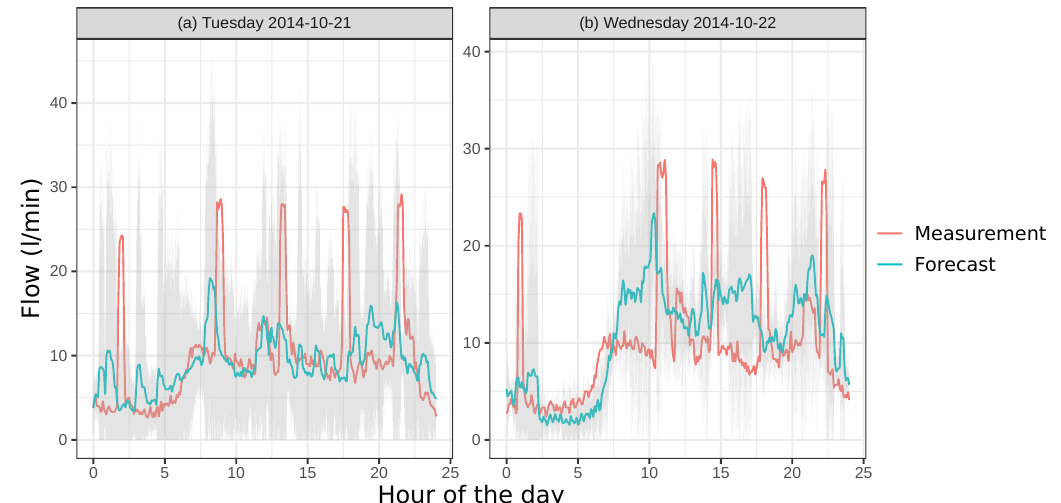
Figure 7. Comparison of two forecasts for the suburban site. The first one (left plot) was flagged as “green” in the FOB plot (FOB = 0.08), while the second (right plot) was flagged as “red” (FOB = 0.51). The grey band represents the 10% pointwise confidence bands.